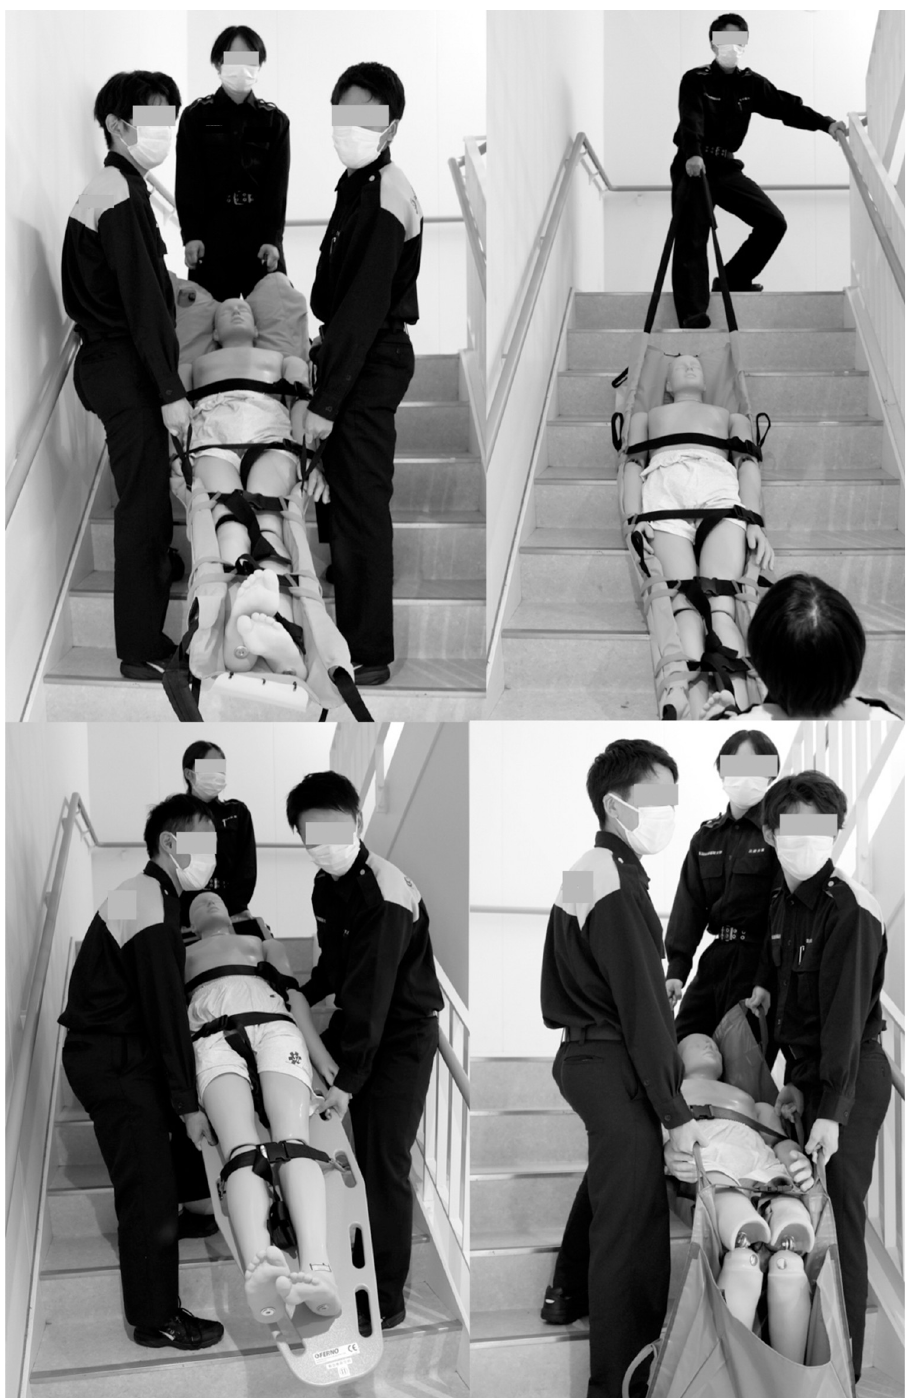
Fig 1. Instruments. The upper left image shows the use of the Airstretcher by lifting. The upper right image shows the use of the Airstretcher by dragging without lifting. The lower left image shows the backboard being carried by lifting. The lower right image shows the tarpaulin being carried by